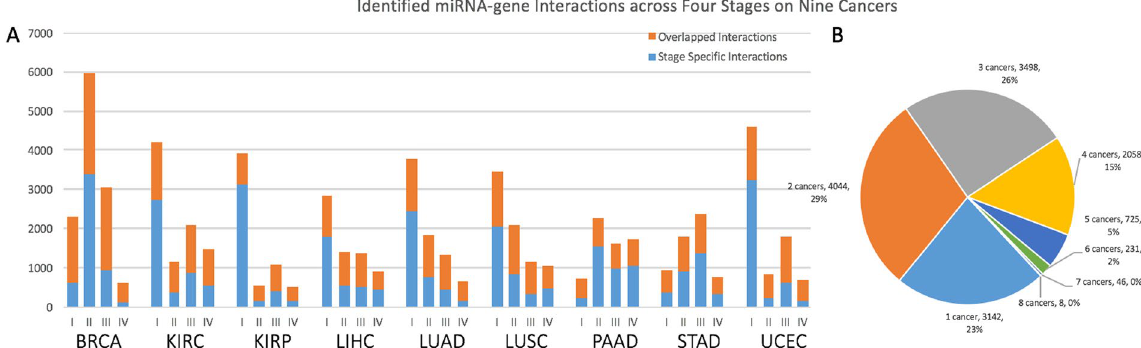
Figure 3. Overview of the miRNA-mRNA interactions identified in nine cancers. ( A ) Number of interactions detected in a specific stage (Blue) versus multiple stages (Orange), in each cancer. ( B ) Pie chart shows the percentages of interactions shared by different cancers.